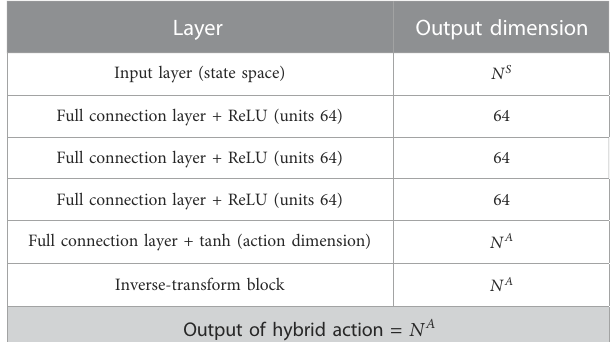
TABLE 1 Policy network